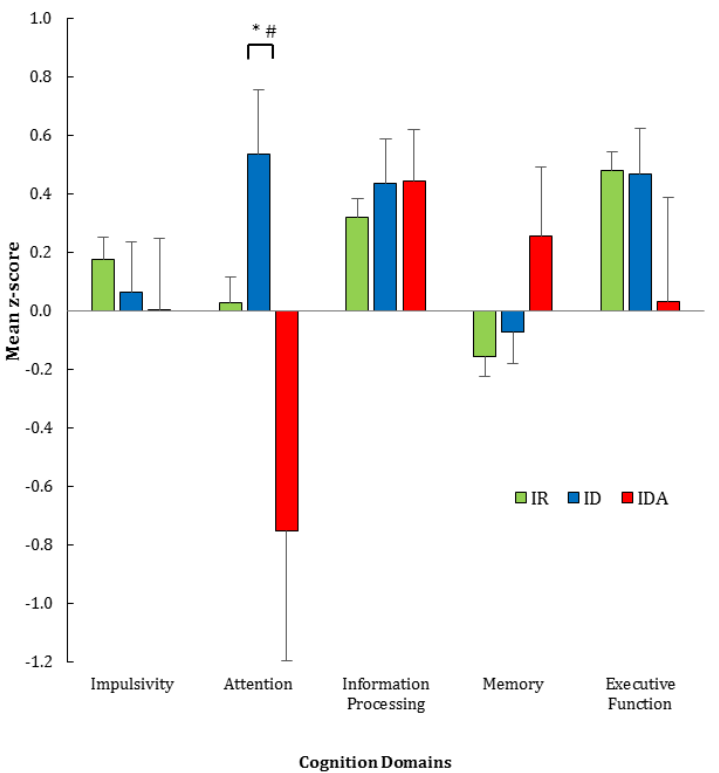
Figure 2. Iron status (IDA, n = 225; ID, n = 42; IR, n = 18) vs. performance in five cognitive domains. Mean z -score ± SE (standard error); normal z -score is +1 to −1. * Denotes p < 0.01 on post hoc tests: IDA vs. ID; # denotes p < 0.01 on univariate analysis IDA vs. ID. Abbreviations: IDA, iron deficiency anemia (hemoglobin < 120 g/L); ID, iron deficiency (ferritin below normal range, but hemoglobin ≥ 120 g/L); IR, iron replete. Domain scores adjusted for age and education. Attention was measured